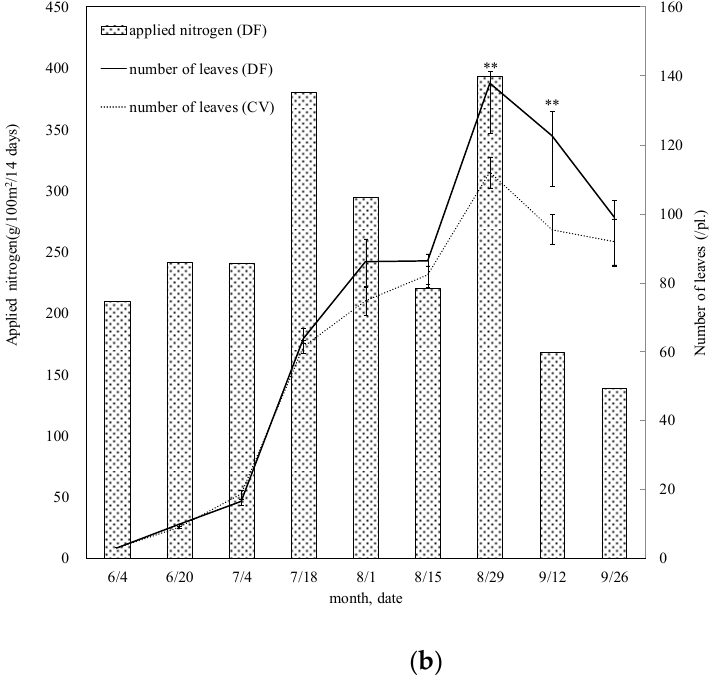
Figure 3. Chronological changes of leaf counts and the applied nitrogen amount in DF. ( a ) 2016. ( b ) 2017. DF, drip fertigation; CV, conventional fertilization. Vertical bars indicate standard error ( n = 5). * and ** indicates significant difference between treatments according to t -test at the 5% and 1% level, respectively.